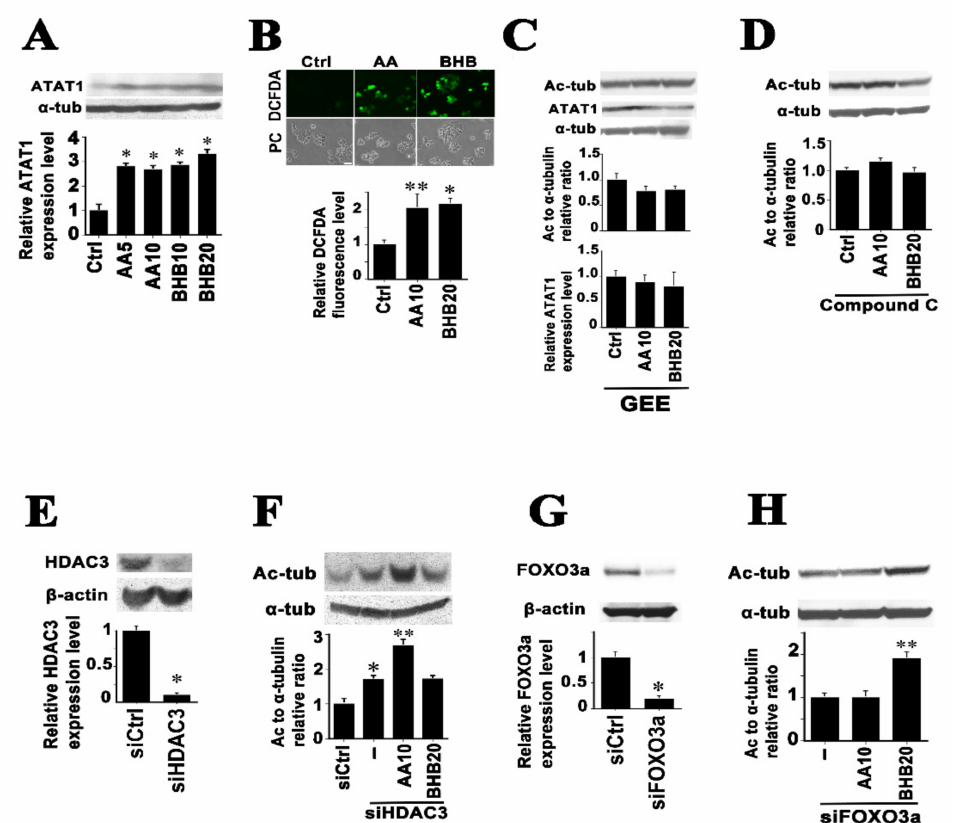
Figure 2. Characterization of the signal molecules for ketone body-induced microtubule hyperacetylation in HCT116 cells. ( A ) HCT116 cells were treated with the indicated concentrations of AA and BHB for three days, and whole cell lysates were then subjected to immunoblotting with the indicated primary antibodies (anti-ATAT1: ATAT1). The relative ATAT1 expression ratios to the controls are indicated in the bar graphs below the panels. Significant increases were detected following both AA and BHB treatments. ( B ) Cells were treated with 10 mM AA or 20 mM BHB for two days and then subjected to DCFDA staining to detect ROS. Significant elevations in ROS generation were detected following both ketone body treatments compared with the controls (upper images; DCFDA, lower images; phase contrast images of the corresponding upper images (PC)). Scale bar, 100 µ m. The quantification of the DCFDA signals is indicated in the graph. ( C ) In the presence of 1 mM GEE, the HCT116 cells were treated with AA and BHB for three days. Western blot analysis revealed no significant increase in either the tubulin acetylation ratios or the ATAT1 protein levels compared with the controls. The graphs show the quantification results. ( D ) In the presence of 10 µ M Compound C the HCT116 cells were treated with AA and BHB. No significant increase was detected in the tubulin acetylation ratios compared with the controls. ( E ) Cells were transfected with siRNAs against HDAC3. An approximately 90% reduction in the level of HDAC3 protein was achieved. ( F ) Under the HDAC3 knockdown, the effects of ketone bodies were examined by western blot. Compared with the control siRNA, an anti-HDAC3 siRNA transfection alone produced a significant increase in the tubulin acetylation level (asterisk in the graph). Compared with an anti-HDAC3 siRNA transfection alone, a significant increase in the tubulin acetylation ratio was detected following AA treatment (double asterisk in the graph) but not in the BHB-exposed cells. ( G ) Cells were transfected with siRNAs against FOXO3a. An approximately 80% reduction in the level of FOXO3a protein was achieved. ( H ) Under the FOXO3a knockdown, the effects of ketone bodies were examined. Compared with an anti-FOXO3a siRNA transfection alone, a significant increase in the tubulin acetylation ratio was detected following the BHB treatment (double asterisk in the graph) but not in the AA-exposed cells. The asterisks and double asterisks indicate significant differences (Student’s t -test, * p < 0.01 and ** p < 0.05,